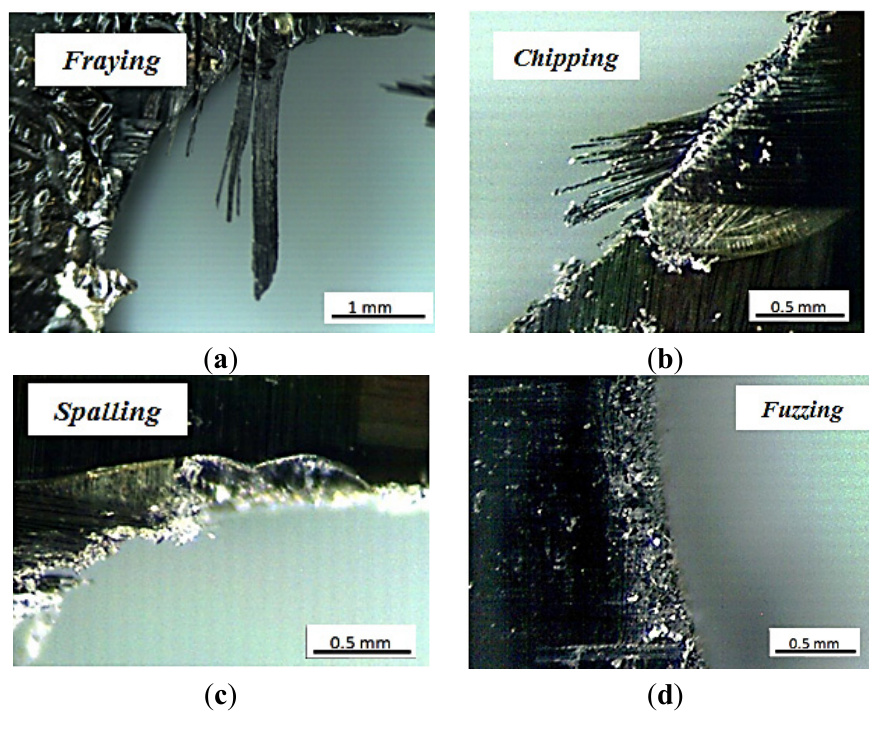
Figure 10. Different defects related with hole quality found after drilling. ( a )